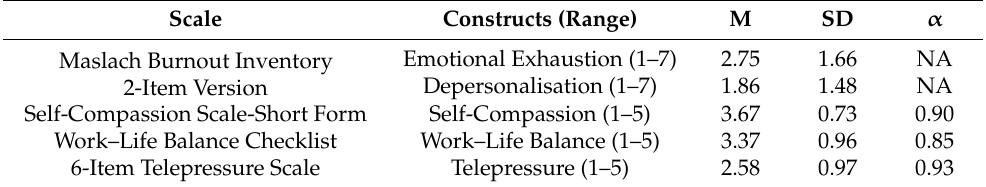
Table 1. Descriptive statistics: burnout, self-compassion, work–life balance and telepressure in professional psychotherapists ( n =